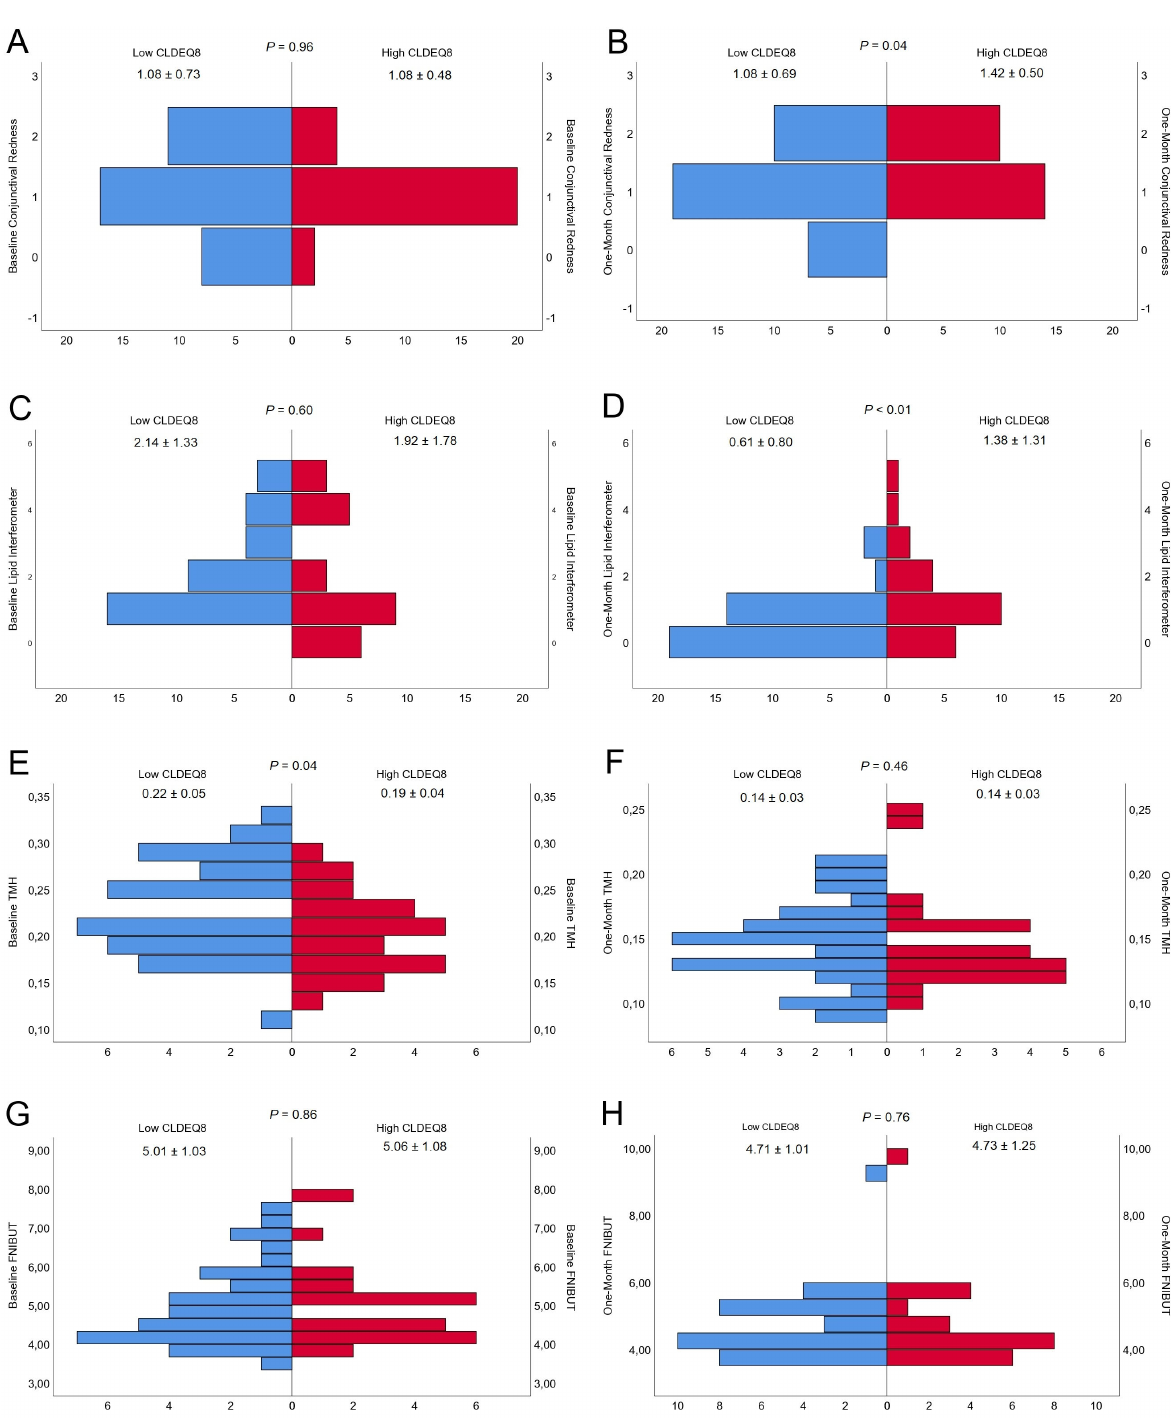
Figure 1. Baseline and One Month Comparison of ( A , B ) Conjunctival Redness, ( C , D ) Lipid Layer Interferometry, ( E , F ) Tear Meniscus Height (TMH), and ( G , H ) First Non-Invasive Break Up Time (FNIBUT). The figure consists of eight pyramid-shaped graphs, with four left representing the baseline measurements and four right representing the measurements taken one month later.